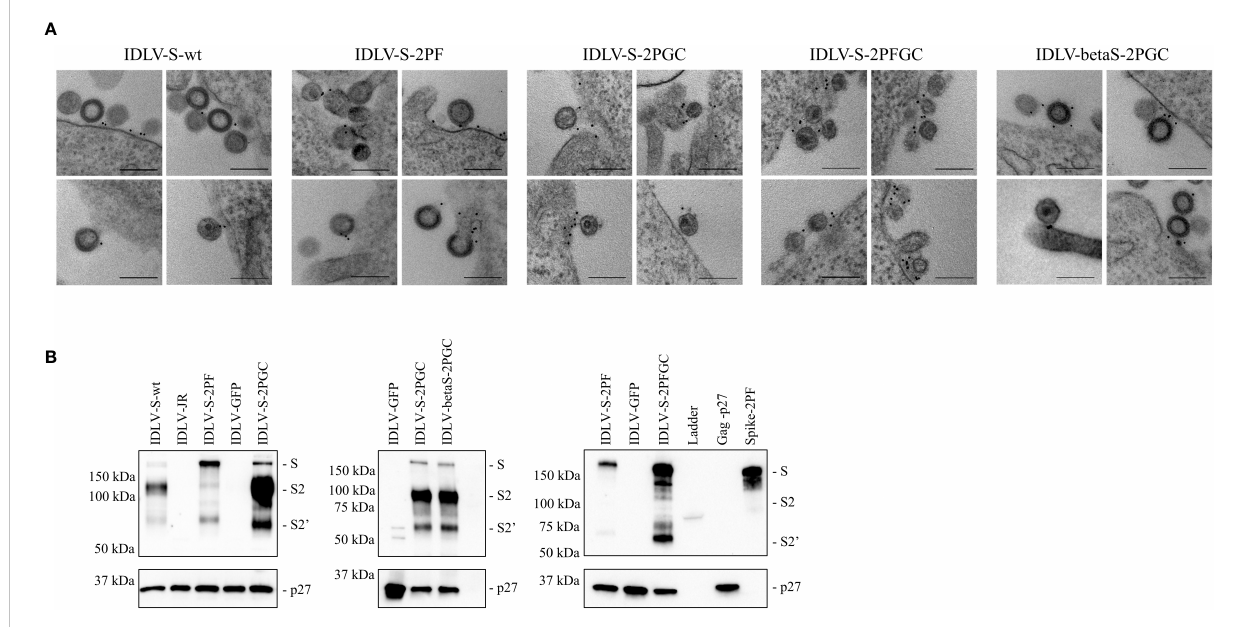
FIGURE 1 (A) IDLVs are pseudotyped with membrane-tethered Spike proteins. 293T Lenti-X cells producing the different IDLV-CoV2 were probed with anti- RBD COVA2-15 or COVA1-16 human mAbs and observed by TEM. Four representative images are shown for each sample. Bars, 0.2 m m. Shown are results from one representative of n = 2 experiments. (B) Spike incorporation on IDLV-CoV2 particles used for immunization. Western blot of lysates from concentrated preparation of IDLV-CoV2 pseudotyped with the different Spike conformations. IDLV-GFP and IDLV-JR are included as mock controls and SIV-Gag p27 protein (50 ng) as positive control. Filters were probed with polyclonal anti-S2 and anti-p27 Gag Abs. Molecular weights are indicated on the left. Bands corresponding to S, S2 and S2 ’ representing full-length and S2 or S2 ’ portion, are indicated. Blots derive from the same experiment and were processed in parallel. Shown are results from one representative of n = 3